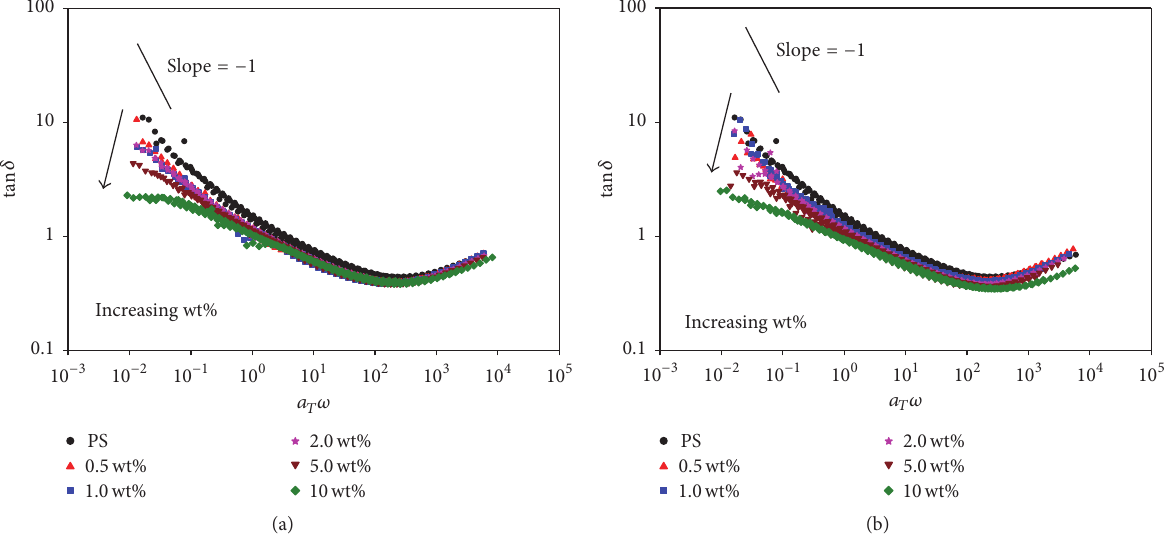
Figure 6: Logarithm tan 𝛿 plot of (a) PS/nanofiber and (b) PS/nanosheet blend in terms of angular frequencies with varying nanofiller